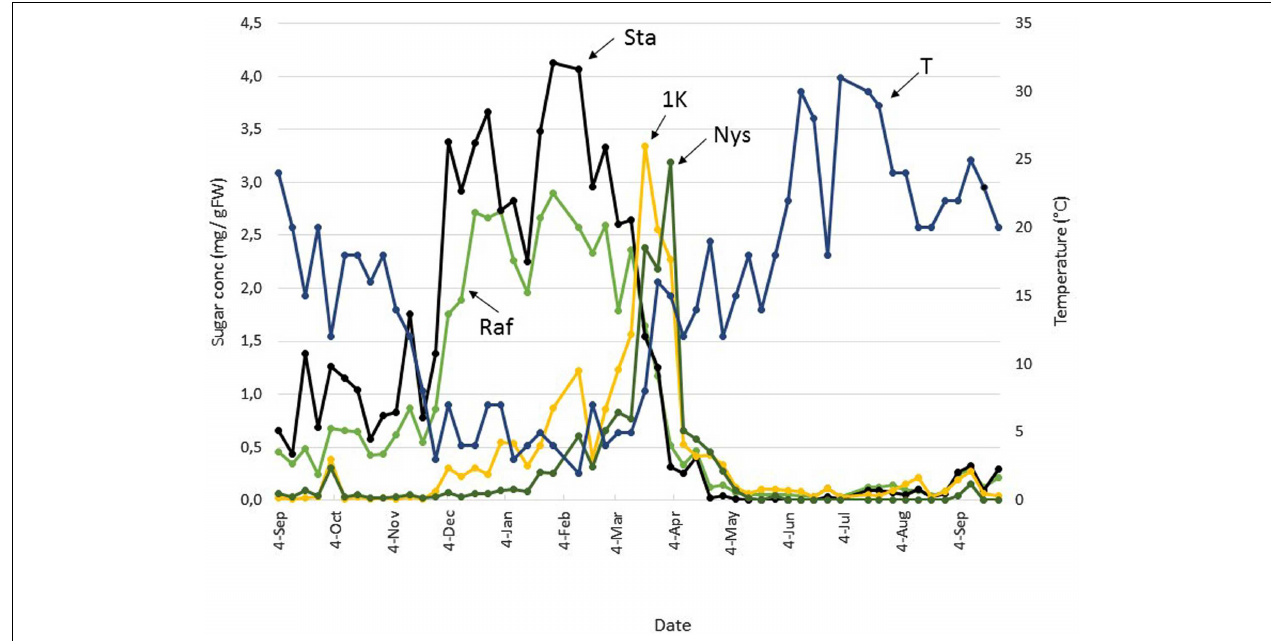
FIGURE 3 | Seasonal FOS and RFO dynamics in Belgian boxtree leaves. The concentrations of raffinose (Raf, green), stachyose (Sta, black), 1-kestotriose (1K, yellow), and nystose (Nys, green) in Belgian boxtree leaves from a 70 year old tree (Langemark-Poelkappelle, Belgium) were followed on a weekly basis over a period of almost 13 consecutive months (left Y -axis). The mean temperature (T) over the same period is also depicted (blue, right Y